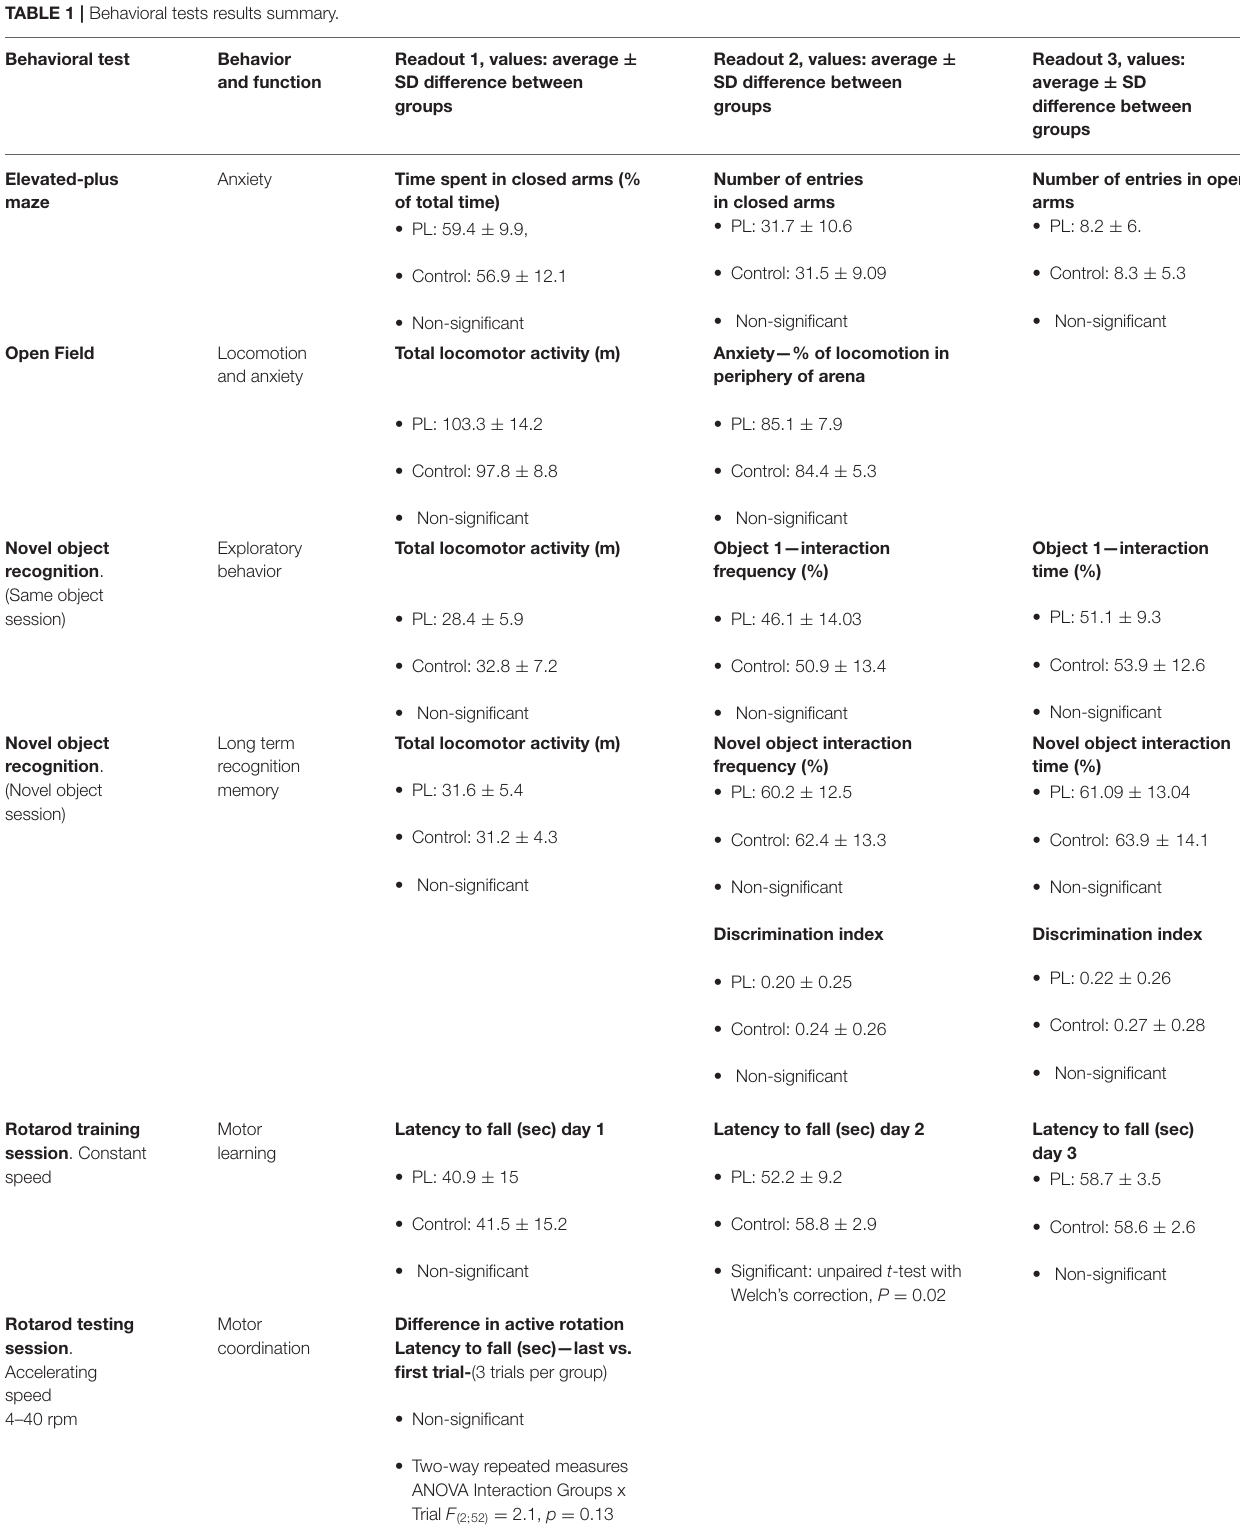
TABLE 1 | Behavioral tests results summary. Behavioral test